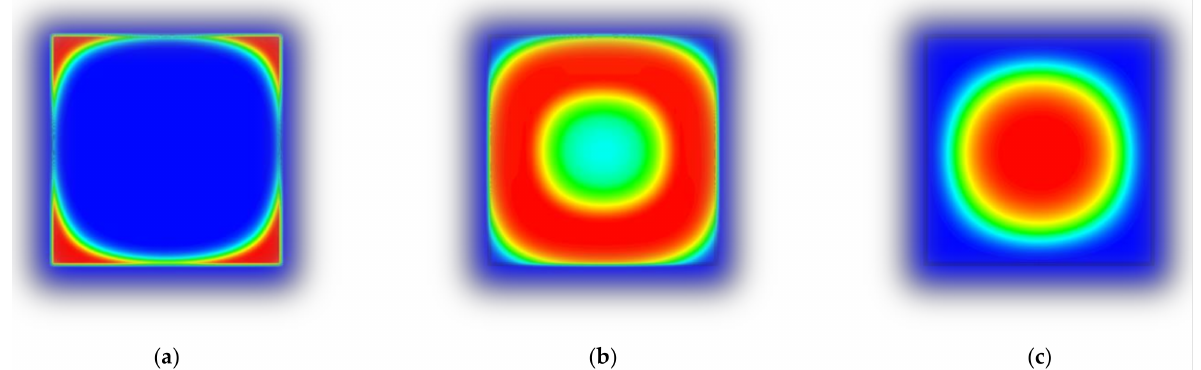
Figure 10. Concentration of char at ( a ) t = 20 s, ( b ) 40 s and ( c ) 60 s.